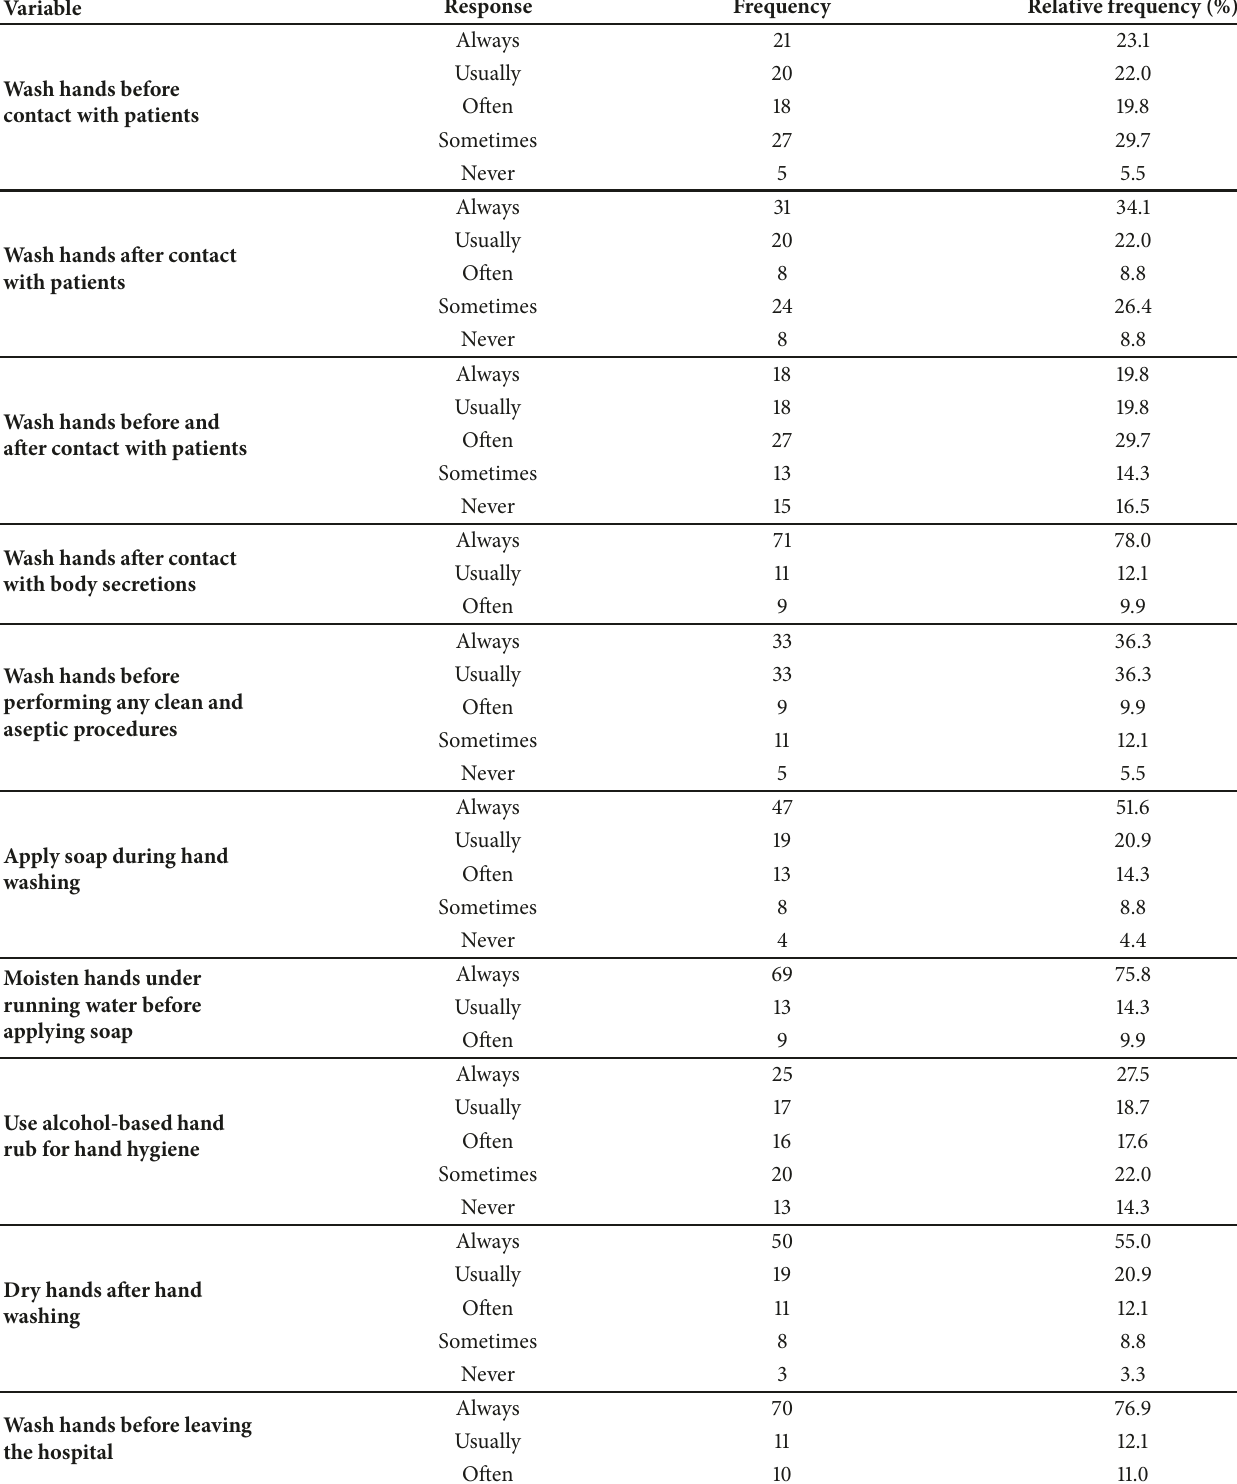
Table 3: Practice of hand washing of study participants in Dubti Referral Hospital, April 2016.